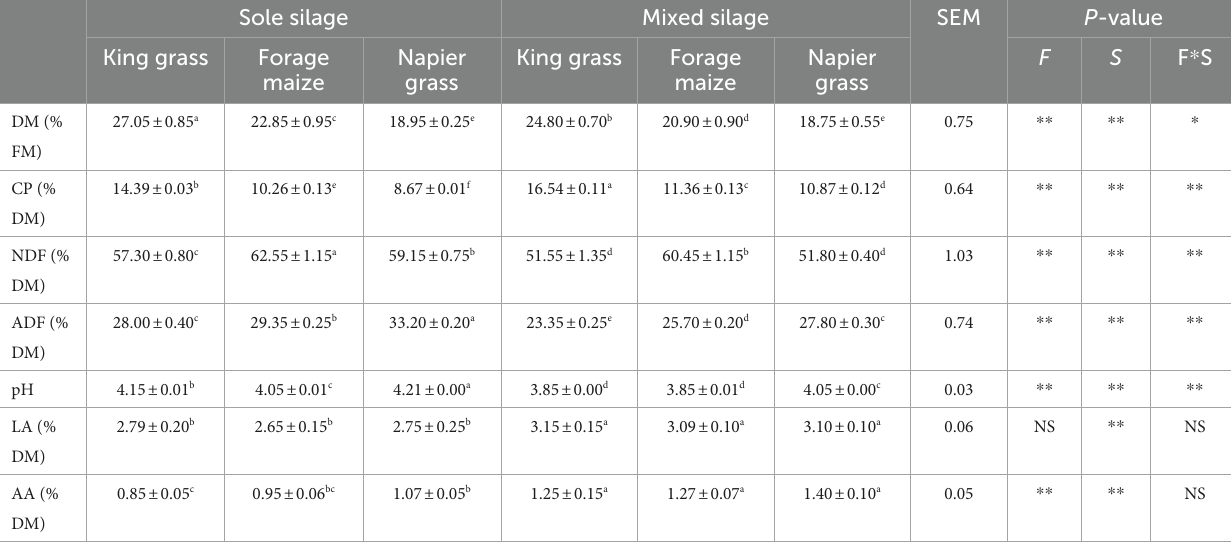
FM, fresh matter; DM, dry matter; WSC, water-soluble carbohydrate; CP, crude protein; EE, ether extract; CF, crude fiber; NDF, neutral detergent fiber; ADF, acid detergent fiber. a–g means values within the same row with different superscripts in lowercase letters differ significantly from each other.